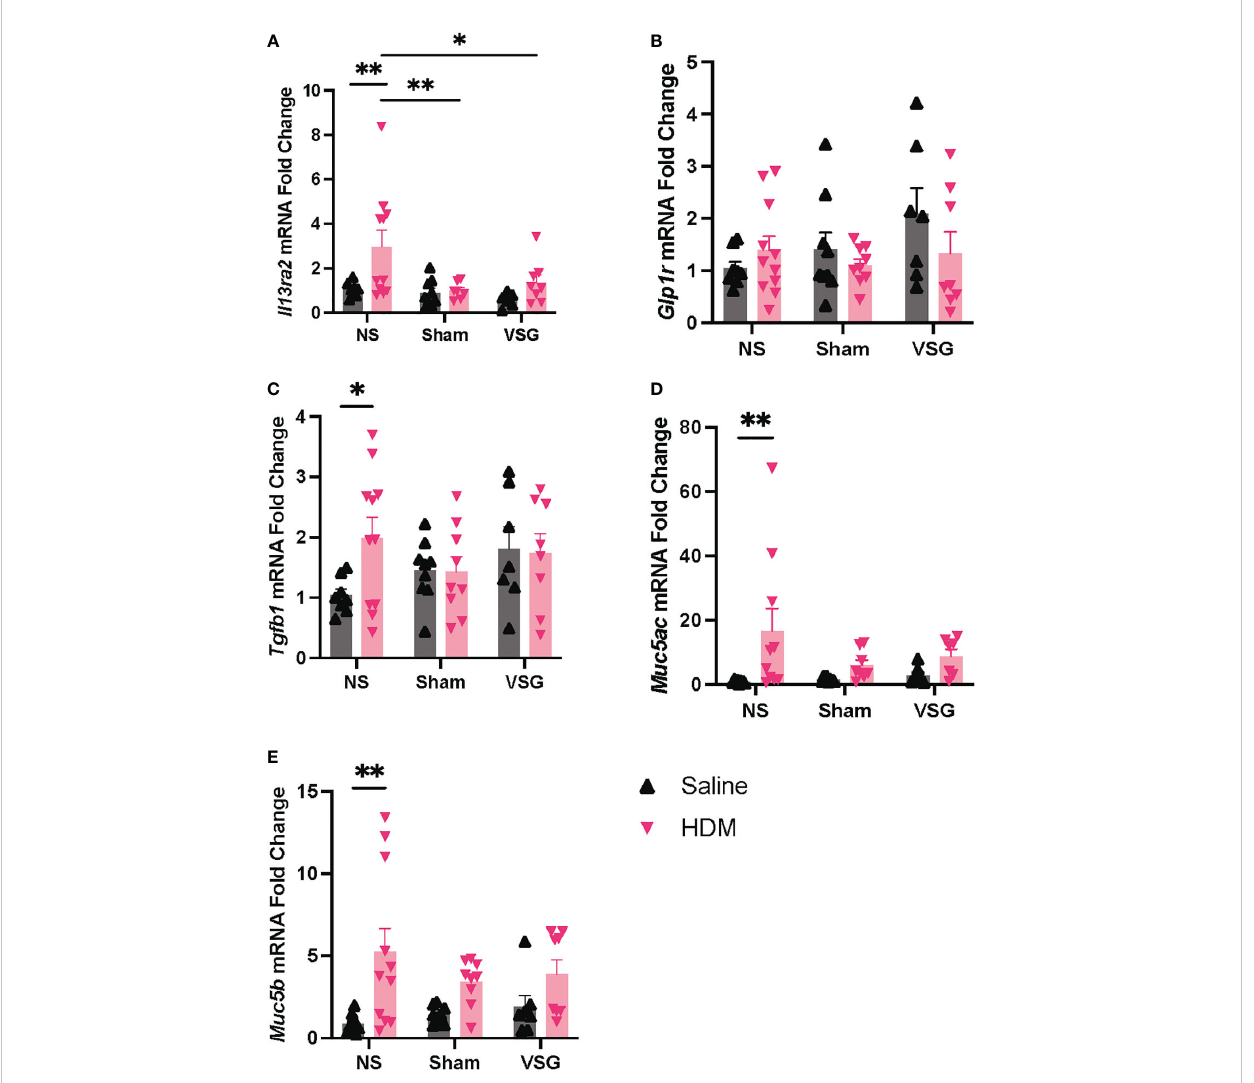
FIGURE 7 mRNA expression in lung tissue. Lung mRNA expression as measured by quantitative RT-PCR of (A) Il13ra2 , (B) Glp1r , (C) Tgfb1 , (D) Muc5ac , (E) Muc5b , n=6-11 mice per group. Grey bars and ▲ = saline-challenged mice; pink bars and ▼ = HDM-challenged mice. (A – E) were analyzed using a Two-way ANOVA with a Tukey and Sidak post-hoc test. *p<0.05,